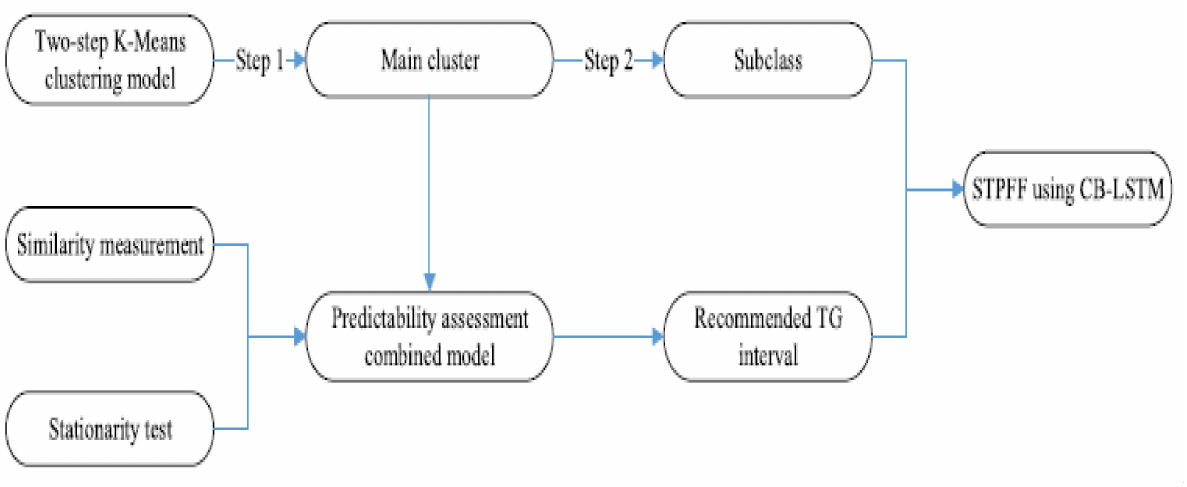
Figure 30. LSTM deep learning framework for passenger flow forecasting